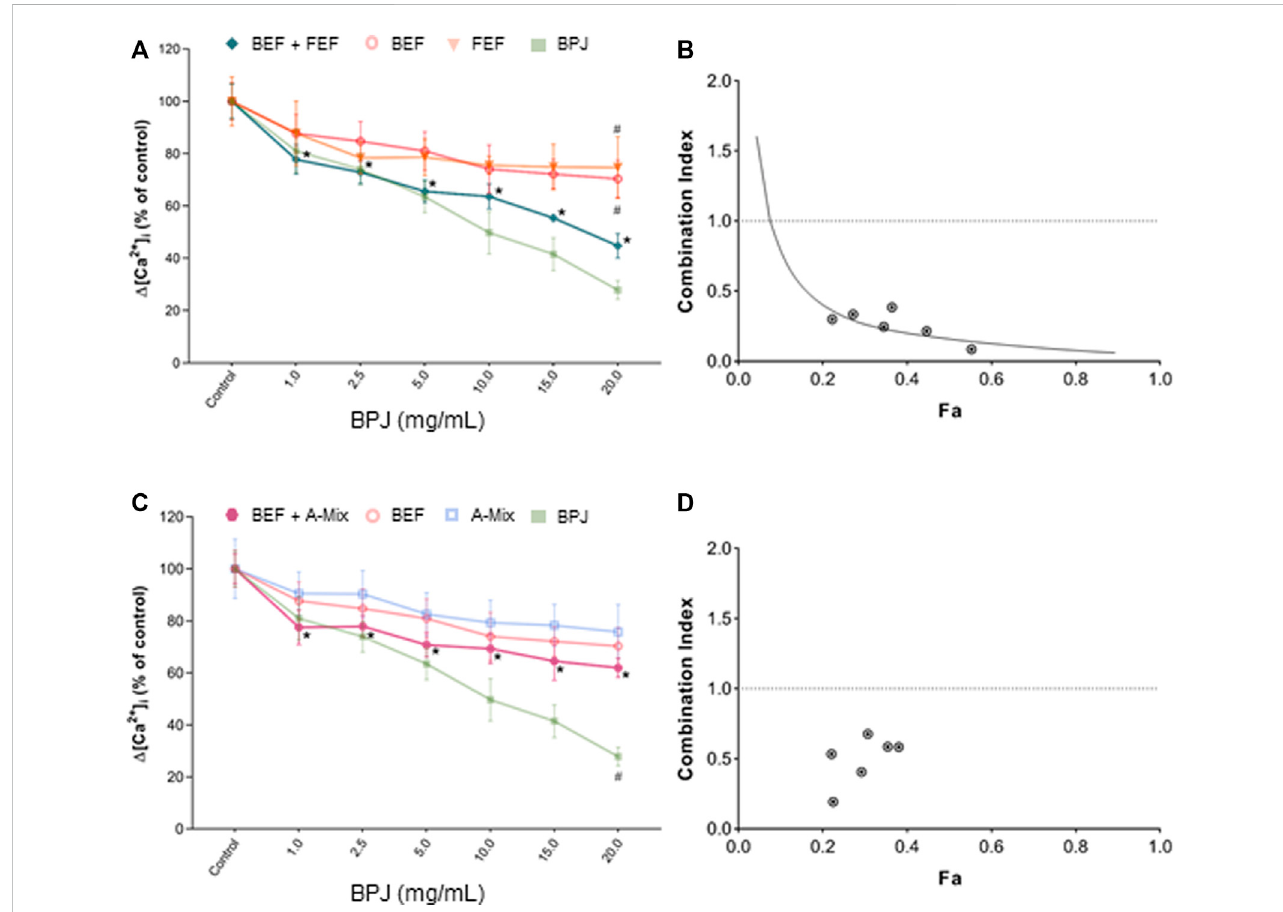
FIGURE 2 Effect of the combination of BPJ fractions/compounds on the OT-induced rise of [Ca 2+ ] i . Cells were pre-treated with BEF plus FEF (A) , or with BEF plus A-Mix (C) prior to stimulation with 100 nM OT. Results of pre-treatment with BPJ and each substance alone are shown in transparent lines (signi fi cance symbols regarding comparison to control omitted). Values represent the mean ± SEM of six independent experiments performed in quadruplicate and are expressed as percentage of control; * p < 0.05 compared with control; # p < 0.05 compared to combination. Combination index (CI) values of the combination of BEF with FEF (B) or with A-Mix (C) were calculated from the concentration-response curves. Data were analyzed by the median-effect method. Fa: fraction